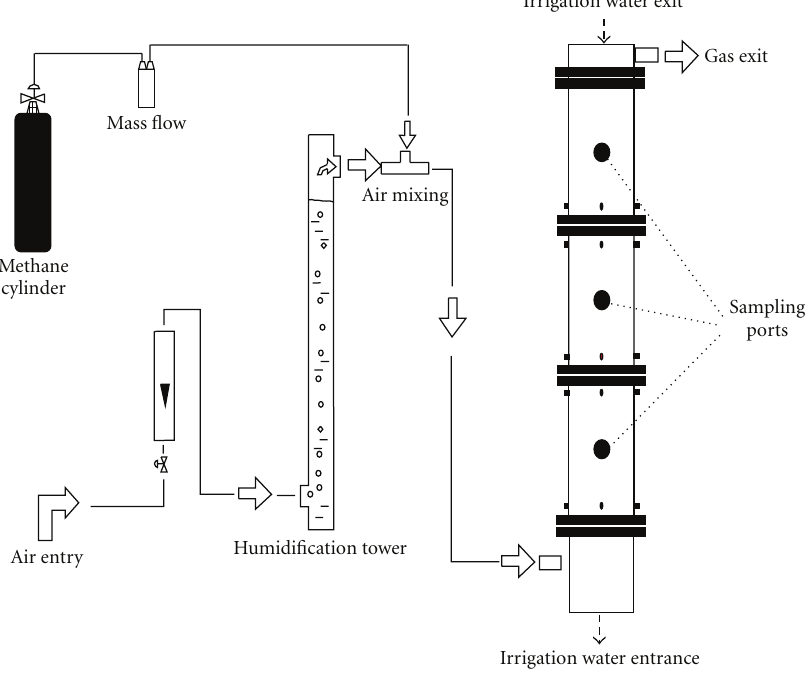
Figure 1: Lab-scale biofiltration